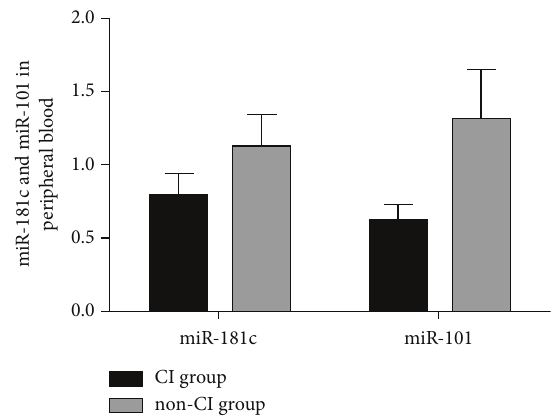
Figure 1: Comparison on relative expression levels of peripheral blood miR-181c and miR-101 between the CI group and the non-CI